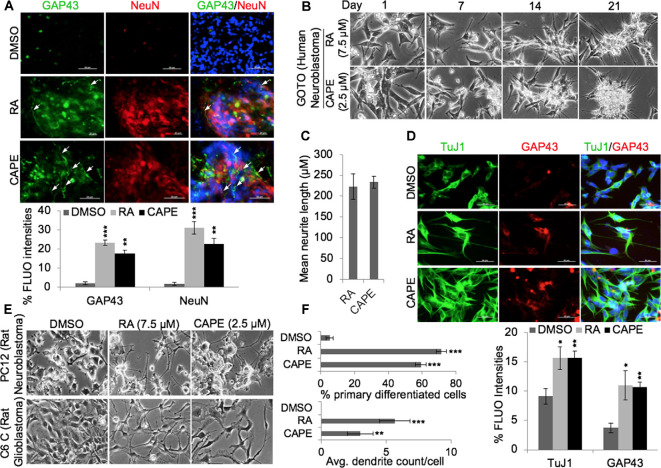
CAPE-induced differentiation was not specific to cell type. (A) Immunofluorescence staining showing expression and distribution of GAP43 and NeuN proteins (neuronal differentiation markers) in control, RA-treated, and CAPE-treated IMR32 human neuroblastoma cells (scale bar, 50 μm). The quantitation of their expressions is shown below. (B) Phase-contrast images showing differentiation phenotype in RA- and CAPE-treated human neuroblastoma cells (GOTO) derived from autonomic ganglia. (C) The quantitation of mean neurite length in RA- and CAPE-differentiated GOTO cells is shown. (D) Immunofluorescence staining showing expressions of TuJ1 and GAP43 in control, RA-differentiated, and CAPE-differentiated GOTO cells. Quantitation of immunofluorescence intensities is shown below the images (scale bar, 50 μm). (E) Phase-contrast images showing differentiation phenotypes post-1 week of DMSO, RA, and CAPE treatments in rat PC12 neuroblastoma and C6 glioblastoma cell lines. (F) Quantitation of the neurodifferentiation phenotype (percentage count of the primary differentiated neuron and average dendrite count per cell of DMSO-, RA-, and CAPE-treated rat PC12 neuroblastoma and C6 glioblastoma cells, respectively) is shown on the right. The data were expressed as mean ± SD. The p-values were represented as *p < 0.05, **p < 0.01, and ***p < 0.001.